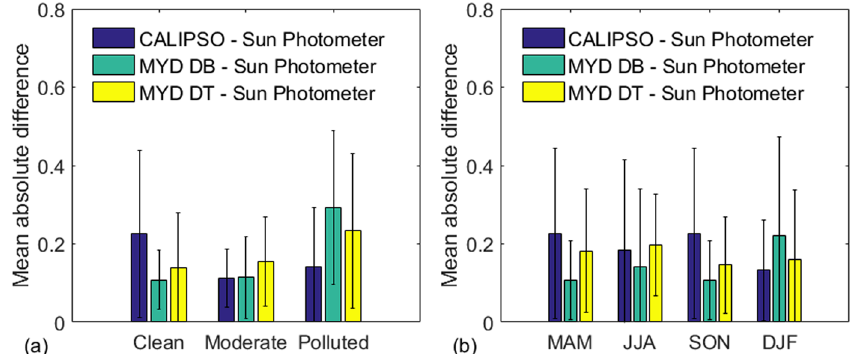
Figure 7. Average absolute bias of AODs under different conditions: ( a ) clean, moderate, and polluted conditions; and ( b ) in March, April May; June, July, and August; September, October, and November; and December, January, and February. Error bars represent standard